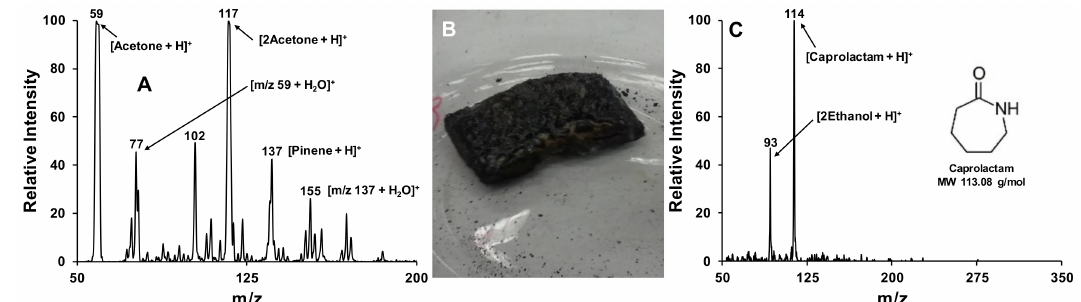
Figure 9. ( A ) APCI-MS spectrum collected from the gaseous headspace emanating from charred pine wood that was burned using acetone as an accelerant. Headspace analysis produces rich spectra, including the protonated acetone in the monomeric ( m / z 59), hydrated ( m / z 77), and dimeric ( m / z 117) forms. The natural product pinene from the wood materials can be seen as both protonated ( m / z 137) and hydrated ( m / z 166) ions. ( B ) Photo showing a charred, nylon carpet sample burned in the presence of ethanol as an accelerant. ( C ) APCI-MS spectrum collected from the gaseous headspace emanating from the charred carpet sample, displaying the protonated ethanol dimer ( m / z 93). Also seen is